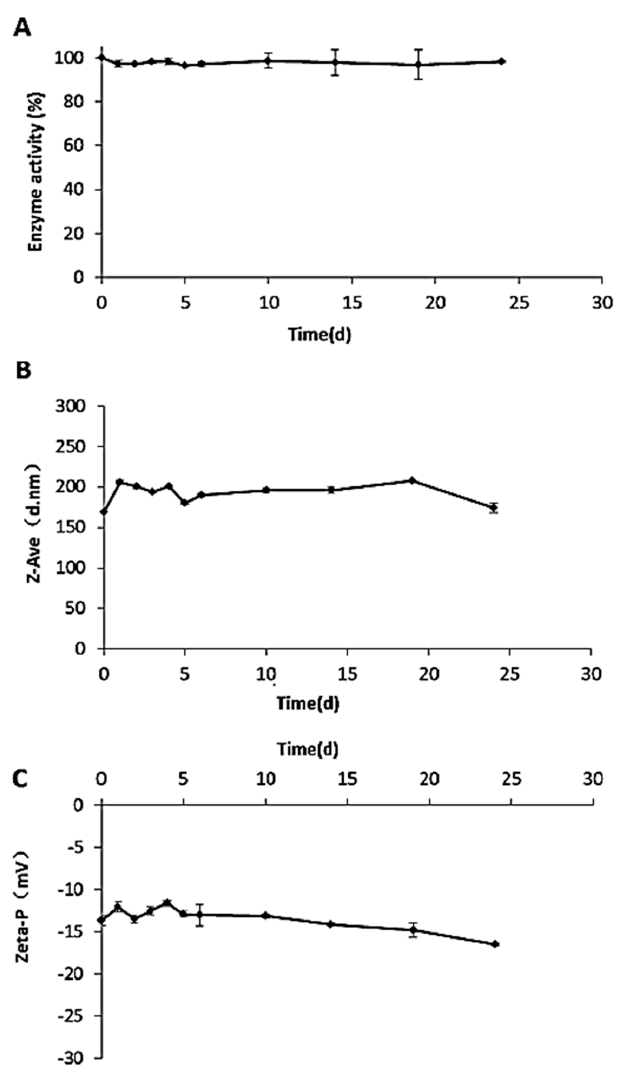
Figure 4. Effect of storage time on the enzymatic activity ( A ); average particle size ( B ) and Zeta potential ( C ) of G-SOD.